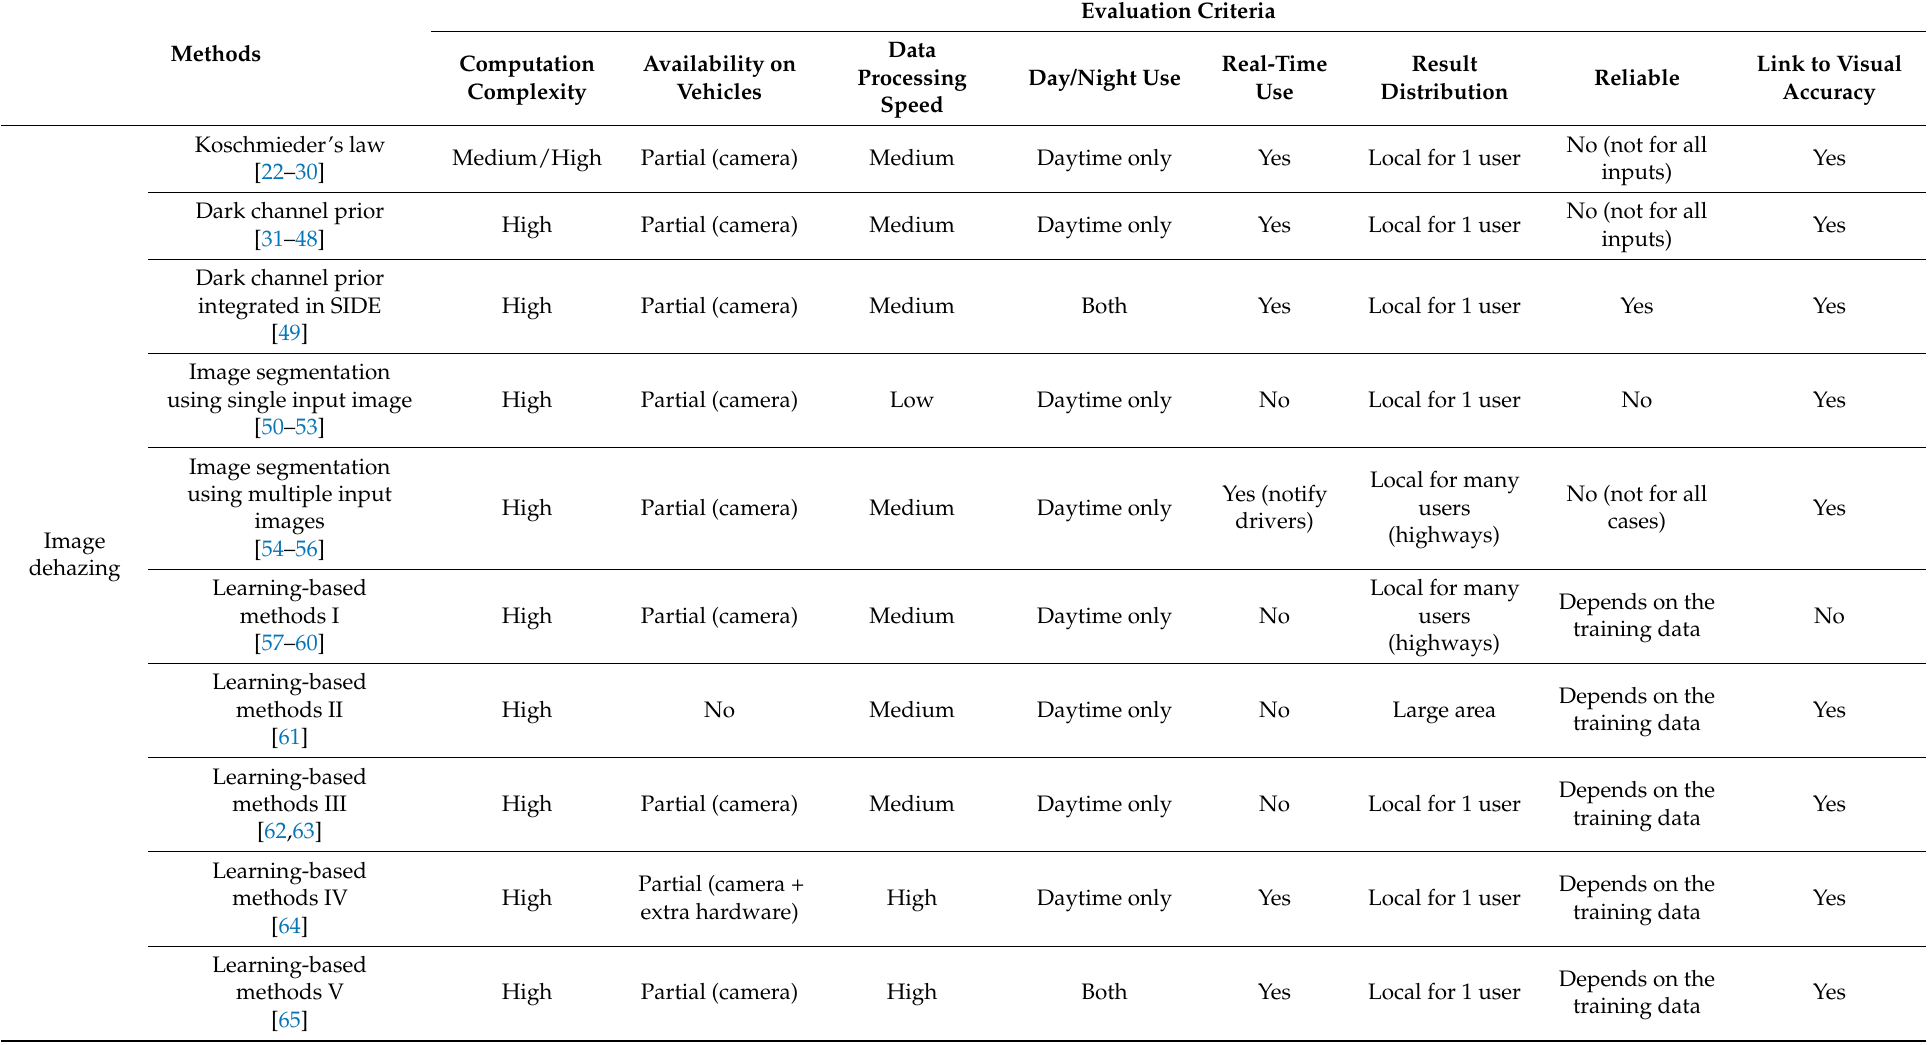
Table 7. Evaluation of the state-of-the-art